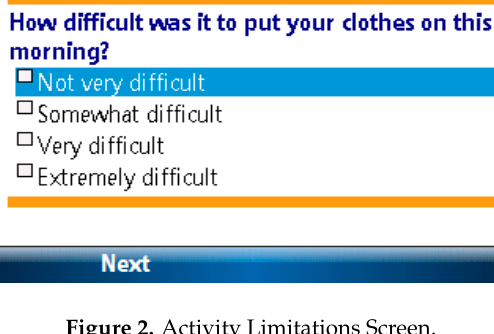
Figure 2. Activity Limitations Screen.